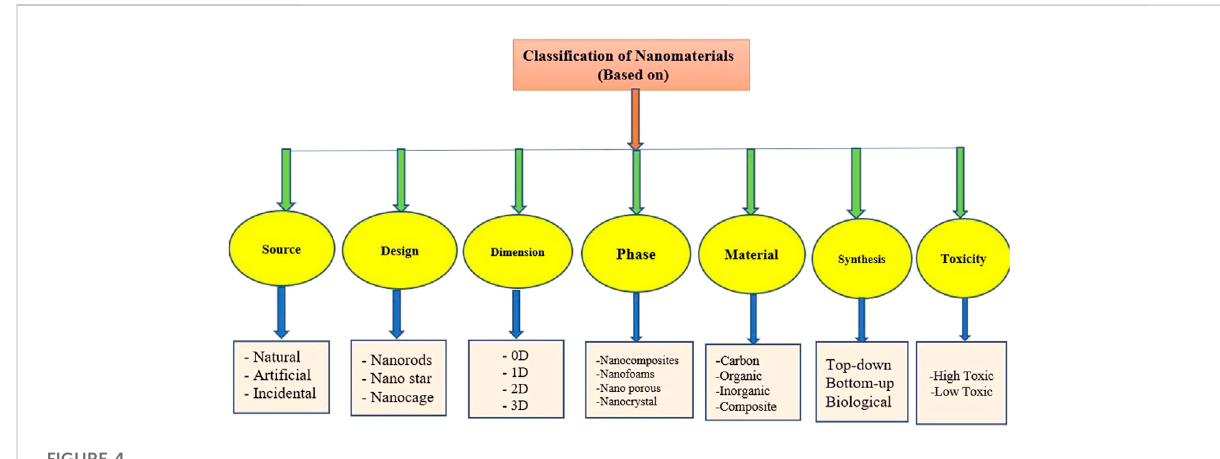
FIGURE 4 Schematic diagram showing classi fi cations of